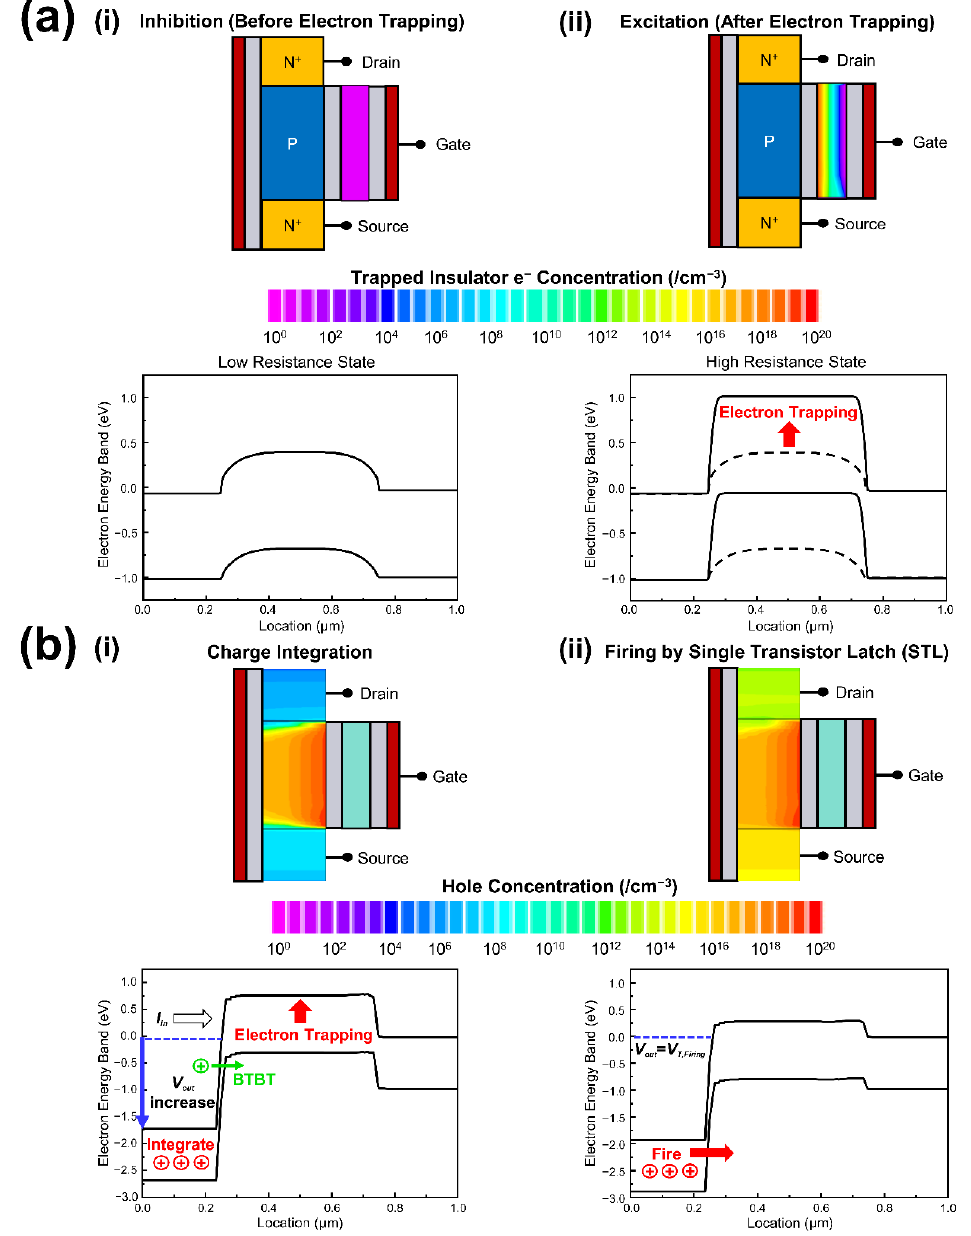
Figure 2. ( a ) Energy band diagrams and contour plots of trapped charges in nitride layer under inhibition mode and excitation mode; ( b ) Energy band diagrams and contour plots of hole concentration under charge integration process and firing process.